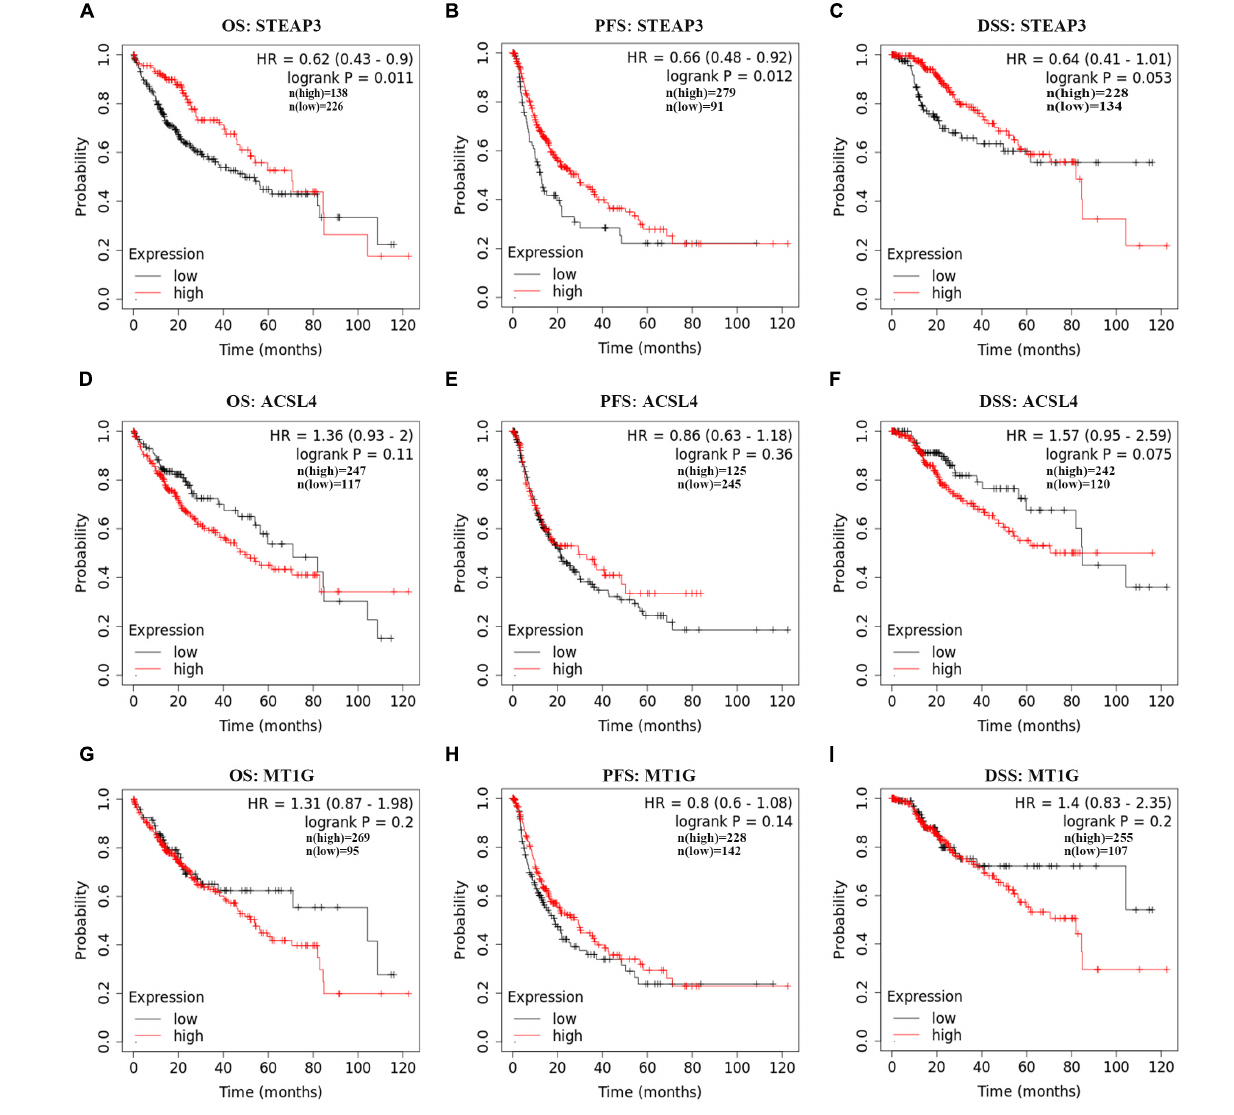
FIGURE 2 | Prognostic values of ACSL4, MT1G, STEAP3 in LIHC. (A–I) The prognostic values of ACSL4, MT1G, STEAP3 in patients with LIHC using Kaplan–Meier plotter database. DSF, disease-specific survivor; OS, overall survival; PFS, progression-free